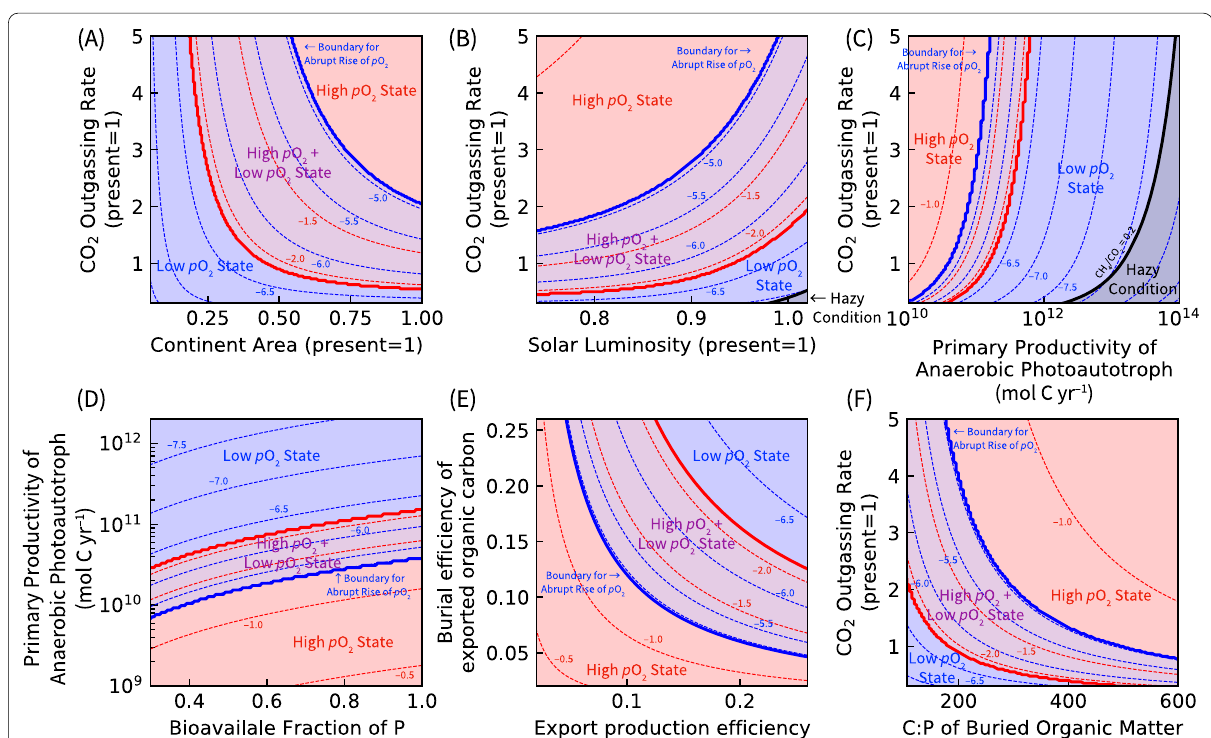
Fig. 5 Dependencies of atmospheric oxygen level on various parameters. Response of atmospheric oxygen levels in the parameter space of A continental area vs. CO 2 outgassing rate; B solar luminosity vs. CO 2 outgassing rate; C the primary productivity of anaerobic photoautotrophs ( F red ) vs. CO 2 outgassing rate; D fraction of bioavailable phosphorus vs. primary productivity of anaerobic photoautotrophs; E burial efficiency of the exported organic carbon ( α ) vs. export production efficiency ( f po ), and F C:P ratio of organic matter buried in sediment vs. CO 2 outgassing rate. Parameters are varied from the condition of F red of 7.50 10 10 mol C year –1 , bioavailable fraction of the riverine phosphorus ( γ bio 1), solar × = luminosity of 83% of the present Earth, CO 2 outgassing rate of present outgassing rate (6.7 10 12 mol C year –1 ), seafloor spreading rate of 1.307 × times the present rate, C:P ratio of organic matter buried in sediment ( R cp,bur ) of 300, burial efficiency of the exported organic carbon ( α ) of 0.2, export production efficiency ( f po ) of 0.1, and soil biological activity ( f e ) of 0.15. The areas filled with red and blue colors represent the conditions where high O 2 levels (> ~ 10 –2 PAL) and low O 2 levels (< ~ 10 –5 PAL) exist, respectively. Thin red/blue dashed line is the contour of the atmospheric oxygen level (PAL). Thick blue and red lines represent the conditions for the transition from the low p O 2 state to high p O 2 state and vice versa, respectively. Thick black line and grey-shaded areas represent the condition of haze formation (CH 4 /CO 2 >